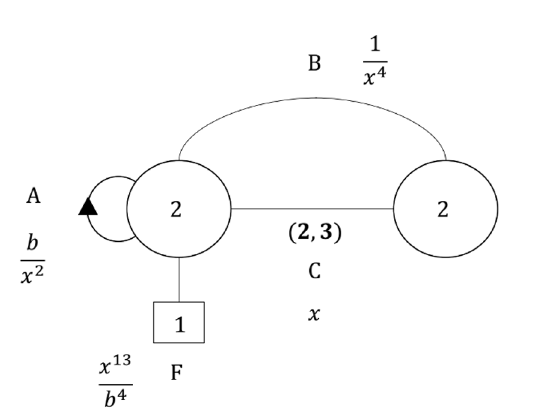
Table 1 . The gauge and matter content of the proposed dual of the rank 1 N = 3 SCFT with dimension three Coulomb branch operator. The (cid:12)eld entry stands for the symbol we used for that chiral (cid:12)eld, where the rest of the entries give the charges of that chiral (cid:12)elds under the gauge and (cid:13)avor symmetries.